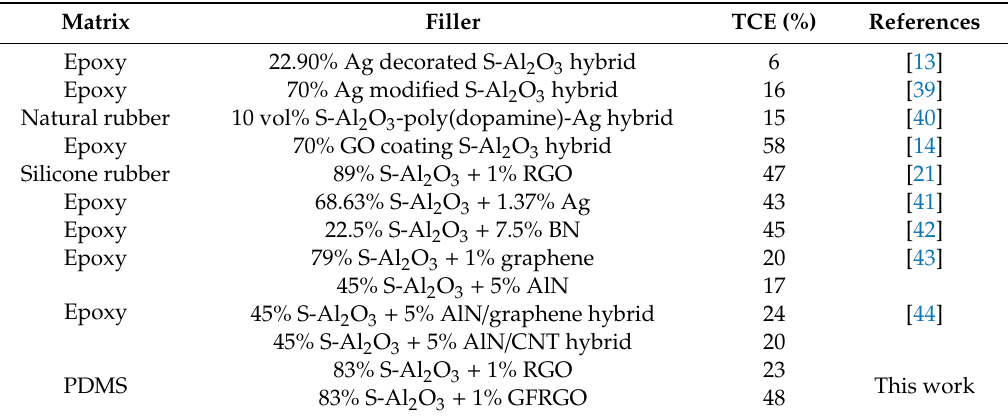
Table 1. Thermal conductivity enhancement (TCE) in polymer-based S-Al 2 O 3 composites.